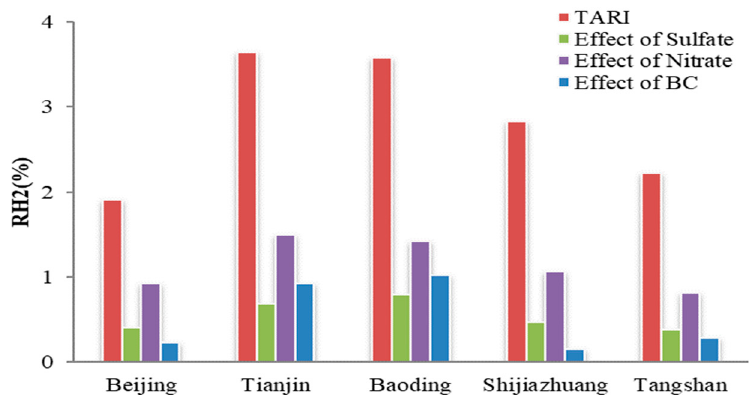
Figure 11. Simulated results of the ARI effect on RH2.